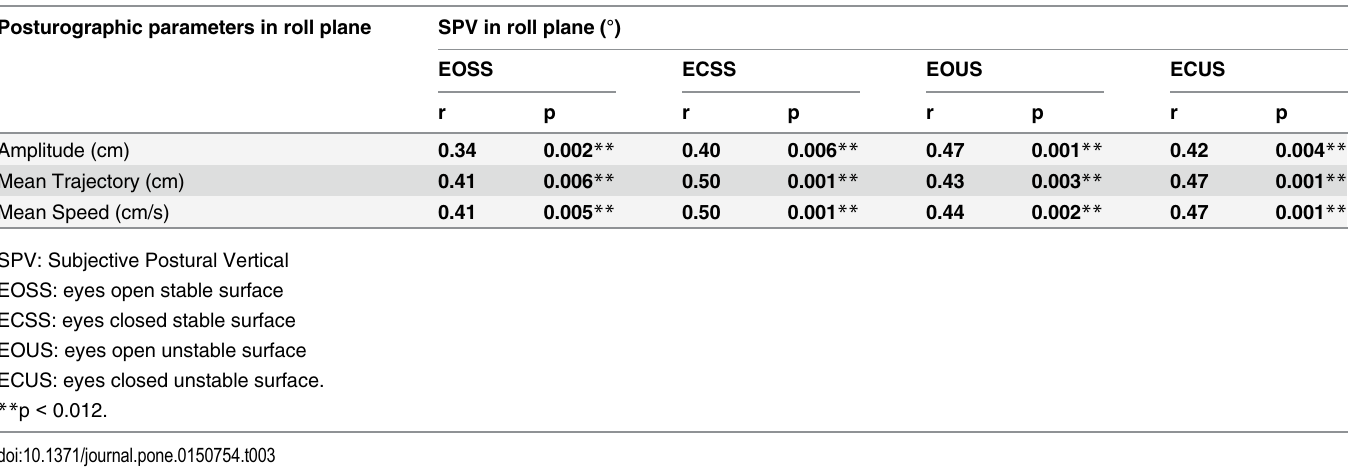
standing position 28 patients completed the EOSS and ECSS conditions, 20 completed the EOUS condition and 16 completed the ECUS condition. In the sitting position, SPV in the roll plane was correlated with amplitude, trajectory and speed parameters as described in Table 3. SPV in roll plane was also correlated with trajectory and speed, in standing ECSS condition, with correlation coefficients of 0.38 (p = 0.02) and 0.35 (p = 0.04), respectively. We did not find correlations between SPV in the pitch plane and any posturographic parameter. For HV, we found a significant correlation between HV in roll plane and trajec- tory and speed in the standing ECSS condition, with correlation coefficients of 0.38 (p = 0.02) and 0.37 (p = 0.03), respectively.